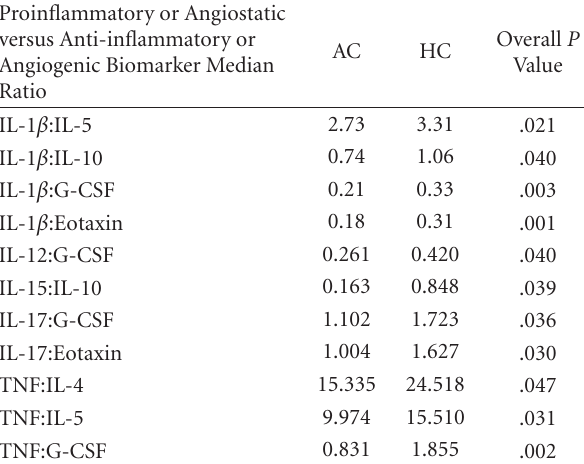
Table 2: Comparison of selected plasma biomarker median ratios between the HC and AC Group. Statistical comparison of median ratios of proinflammatory, angiostatic versus anti-inflammatory and angiogenic factors in di ff erent subject groups. P < . 05 considered statistically